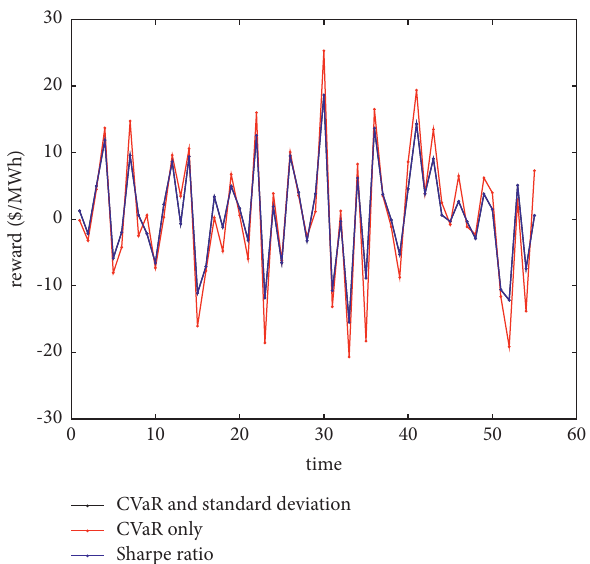
Figure 5: The expected returns of three models in future 45